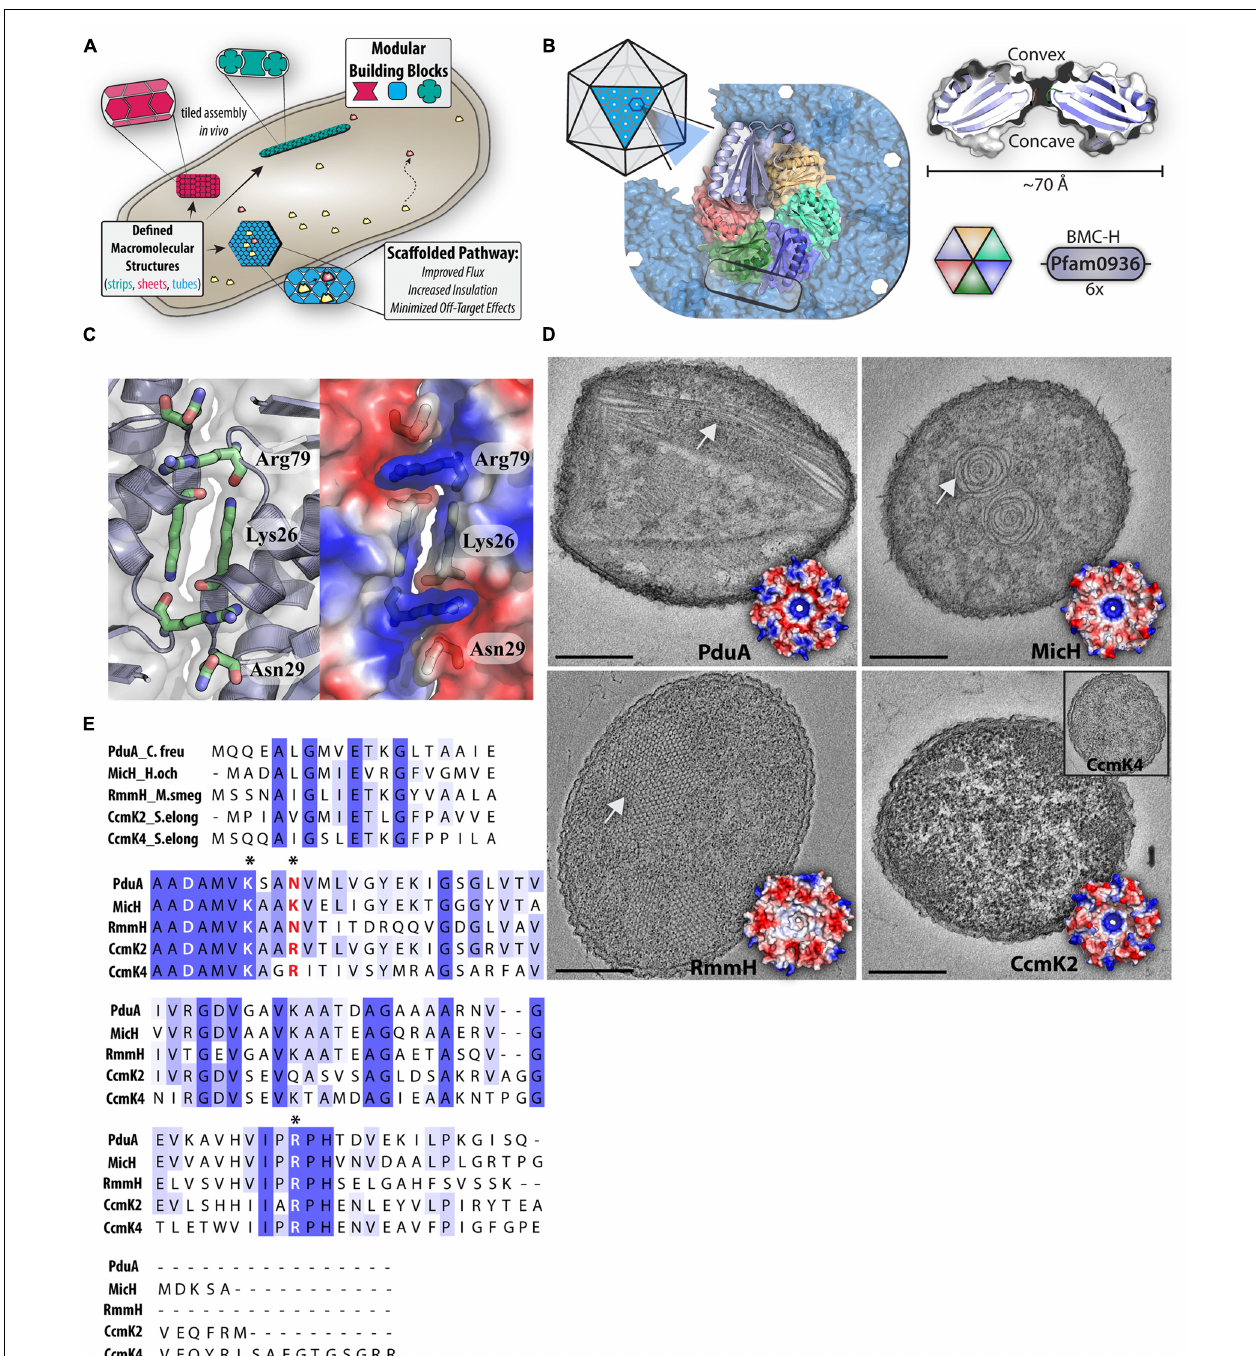
FIGURE 1 | BMC-H attributes and potential as modular building blocks. (A) Cartoon schematic depicting distinct BMC hexamers (red, blue, and green) assembling into modular intracellular architectures that can recruit and concentrate cytosolic proteins (yellow and orange). (B) General features of BMC hexamers are highlighted through the example protein, PduA. A cross-section of a hexamer (right) illustrates the conserved shape and pore, while a hexamer is shown as part of a larger facet (left) that assembles through hexamer–hexamer contacts (box). (C) An expanded view of the interface between two BMC-H protein (PduA, PDB:3NGK), highlighting electrostatic interactions mediated by key residues (blue = positive). (D) Transmission electron microscopy of different assemblies of heterologously expressed BMC-H proteins in E. coli [PduA: Nanotubes (PDB:3NGK), MicH: Rosettes (PDB:5DJB), RmmH: Nanotubes (PDB:5L38), CcmK2: Lack of structure (PDB:4OX7)] Inlet: CcmK4. Scale bar 250 nm. (E) Multiple sequence alignment of representative BMC-H proteins. Asterisks indicate key residues positioned at the hexamer-hexamer interface.